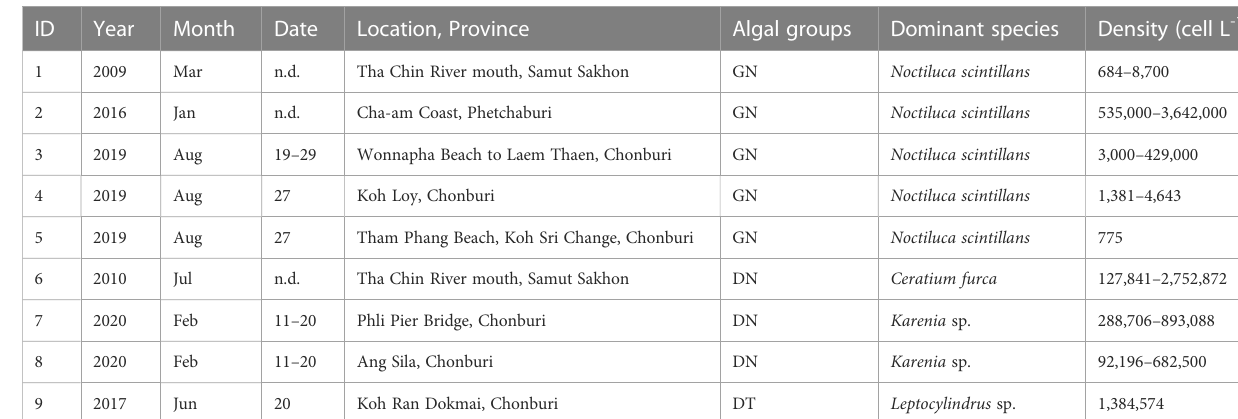
dino fl agellate blooms was also observed in the bloom spectra in the East China Sea (Shang et al., 2014; Tao et al., 2015). Group 6. Cyanobacteria blooms (CN>50%) were found in high chl-a waters with lower abundances of diatoms and dino fl agellates (Figure 3E). R rs spectra with values gradually increasing from blue to green wavelengths were generally similar to those of DN>60% and DT>80% (Figure 3K). Otherwise, the increase in R rs of cyanobacteria in the orange to red range was greater than that for dino fl agellates, particularly from 645 to 678 nm. Group 7. Cryptophytes dominated a mixed red tide population observed in samples with medium chl-a concentration (Figure 3F). Because cryptophytes have never been proven to cause red tides in the uGoT, we refer to this group as mixed (MX) bloom water. The R rs spectra gradually increased from blue to green, peaking in the yellow band (max. between 568 and 571 nm; 0.0026 to 0.0031 sr -1 , Figure 3L). This characteristic was similar to that of DT>80% blooms, but the R rs values were much lower. Normalizing the R rs spectra by R rs 547 (Figure 3M – R) helped highlight the differences in spectral characteristics for each algal bloom type. Normalized R rs spectra, particularly in the blue (451 – 490 nm), green (491 – 560 nm), and red (581 – 700 nm) bands, showed the unique spectral characteristics of green Noctiluca in comparison to the other groups. Green Noctiluca had low normalized R rs values in the blue and red wavelengths and a peak in the green band. These characteristics became clearer as the bloom intensity increased. Normalized R rs spectra of DN>60% and CN>50% blooms, as well as DT>80% and MX blooms, were higher in red and blue-to-green wavelengths than those recorded for strong and weak GN blooms. These distinct spectral characteristics in the blue, green, and red wavelengths, which are expressed by the water color, provide an opportunity to distinguish green Noctiluca blooms from other blooms using satellite ocean color data. Differences in the spectral signatures of in situ normalized R rs values in blue, green, and red bands (Figure 3M – R) were utilized